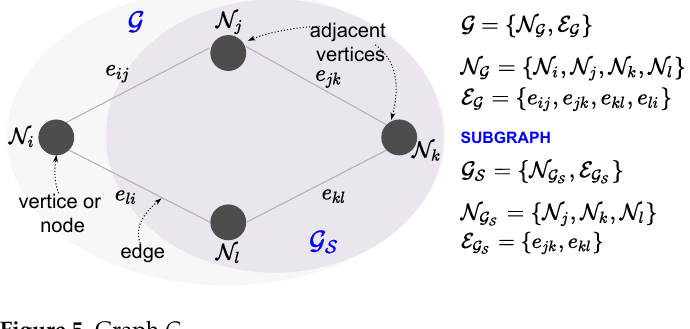
Figure 5. Graph G .